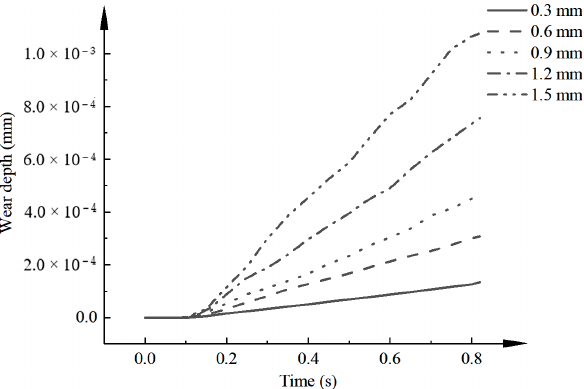
Figure 18. Total wear of sealing surface at different particle sizes.